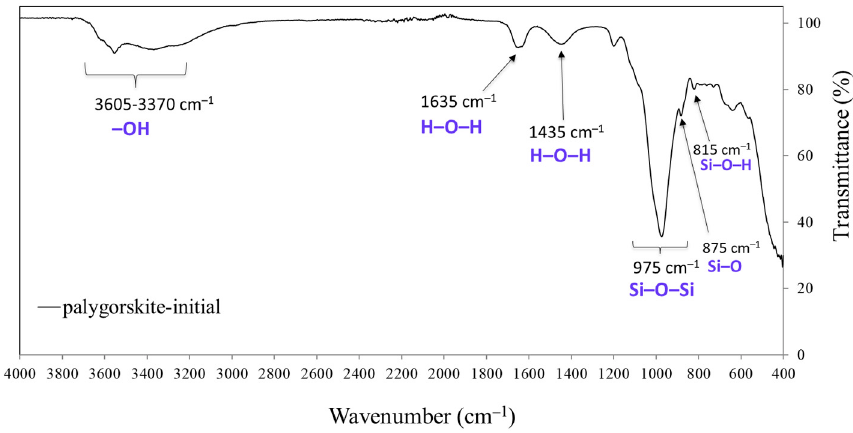
Figure 1. Fourier transform infrared (FTIR) spectra of initial palygorskite—black line.